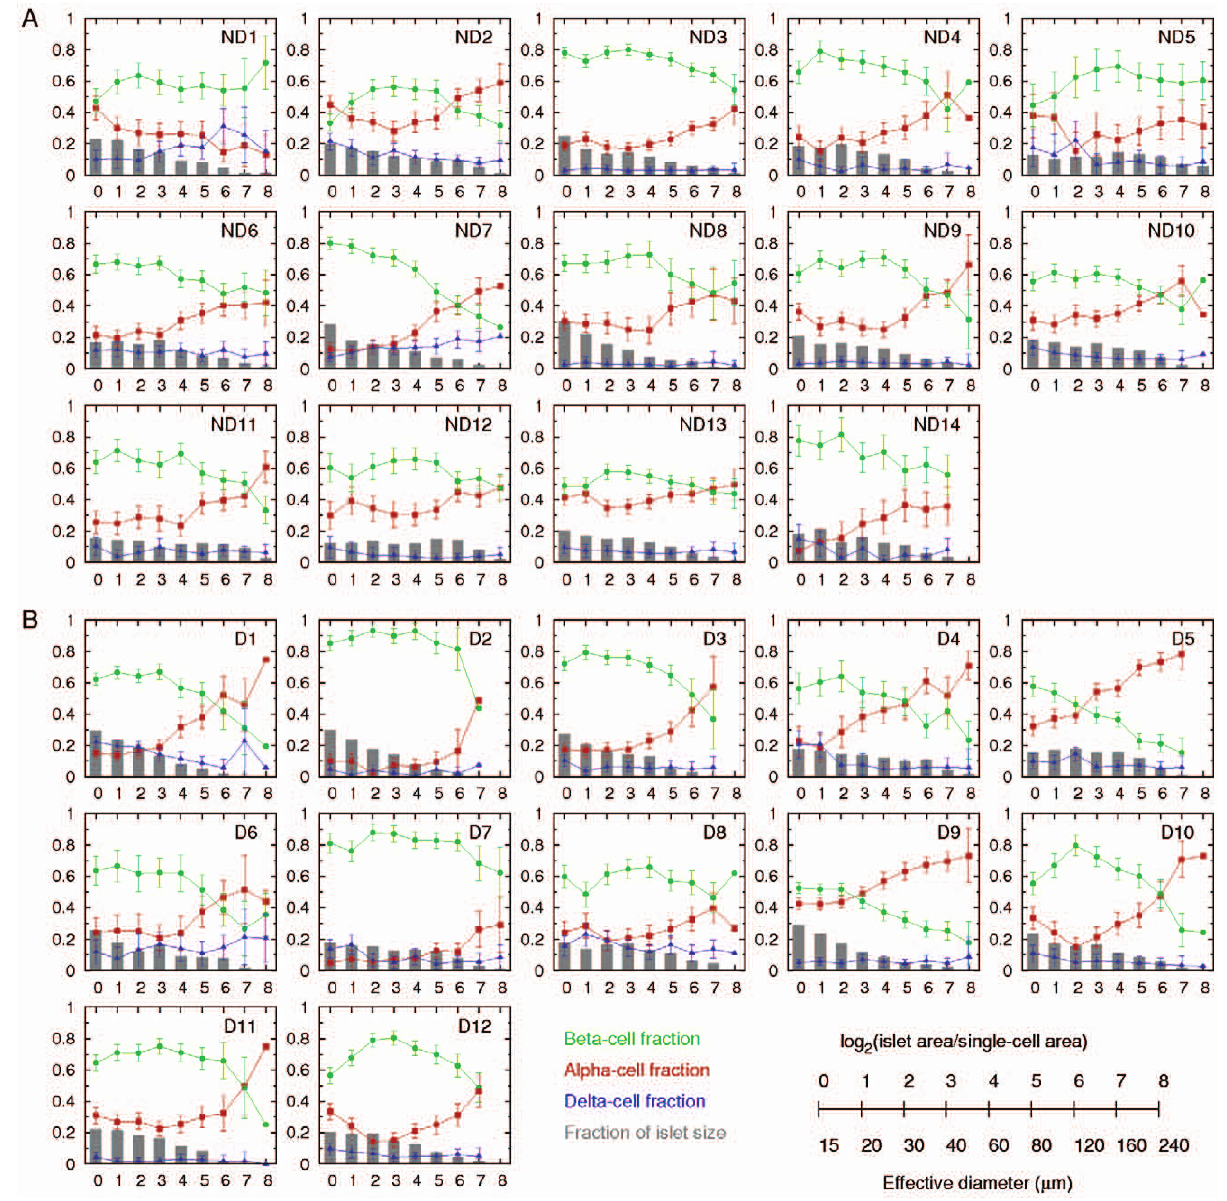
Figure 5. Individual islet size distribution and cellular compositions. A: In non-diabetic subjects (ND1–ND14), relative frequency of islet size (gray bar) and ratios of alpha (red), beta (green), and delta (blue) cells within islets were plotted against islet size; means 6 SEM. B: Results in T2D patients (D1–D12). Note that islet size is presented as a logarithmic scale considering the high number of small islets and the low number of large islets. In addition, we divided islet areas by the single-cell area, 170 m m 2 [29], to make them as dimensionless values representing the number of cells in a given islet area. The conversion between logarithmic islet area (logarithmic) and effective diameter ( m m) is shown.